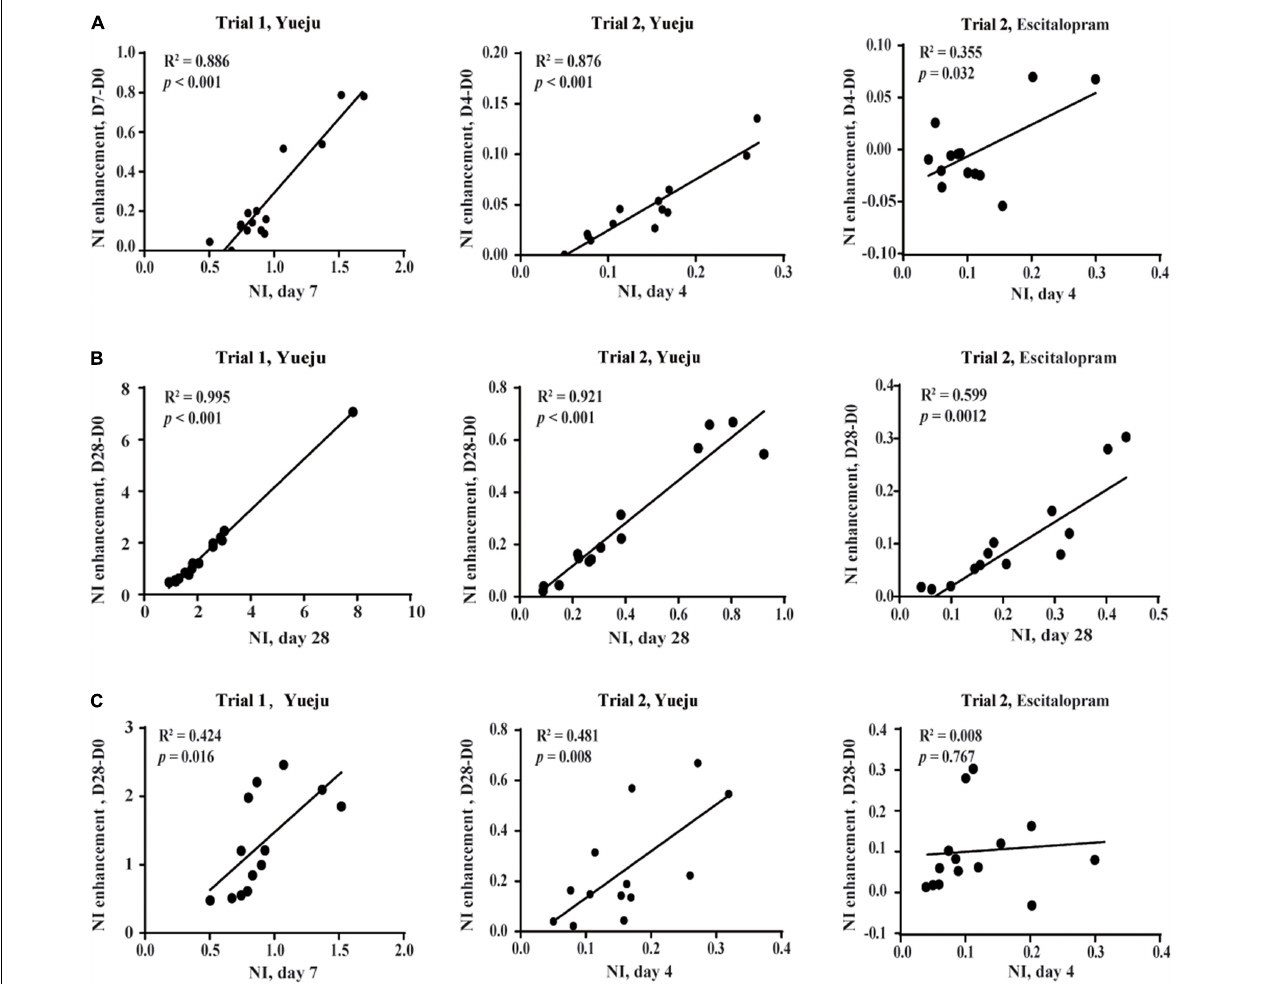
FIGURE 5 | Correlation analysis of NI enhancement, the change of NI within a given period of time. (A) The correlation between early NI and early NI enhancement. (B) The correlation between final NI and final NI enhancement. (C) The correlation between early NI and final NI enhancement. The early NI was on D7 of Yueju treatment in Trial 1 and on D4 of Yueju or escitalopram in Trial 2. The early NI enhancement was the difference of NI between D7 and D0 in Trial 1 and between D4 and D0 in Trial 2. The final NI was on D28 and the final NI enhancement was the difference of NI between D28 and D0 in both trials.